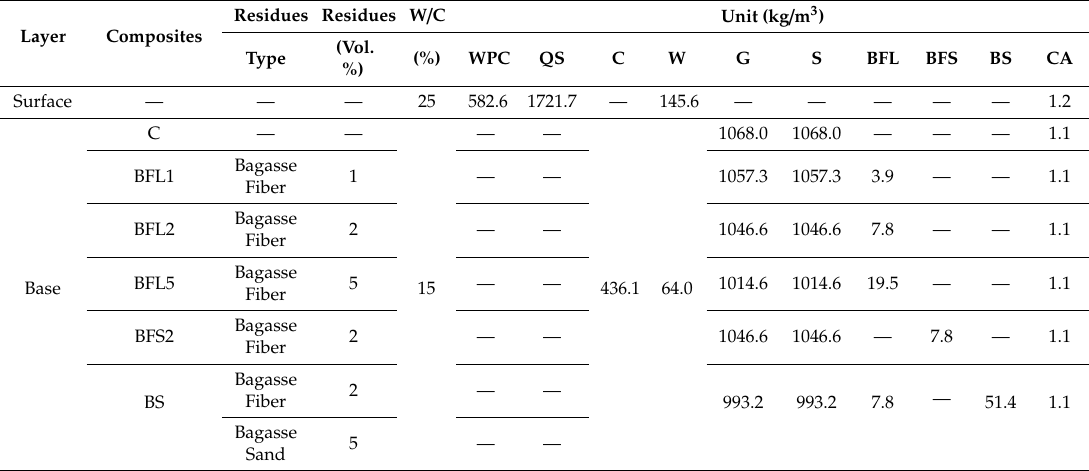
Table 2. Mix proportions of the surface and base layer of specimens.